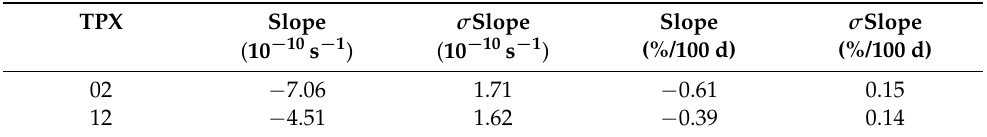
Table 19. Slope of time history of the luminosity ratio measured by layers 1 and 2 for TPX02 and TPX12. The slope values and the uncertainties are given per second and in percentage per 100 days. Taken from Ref. [14].